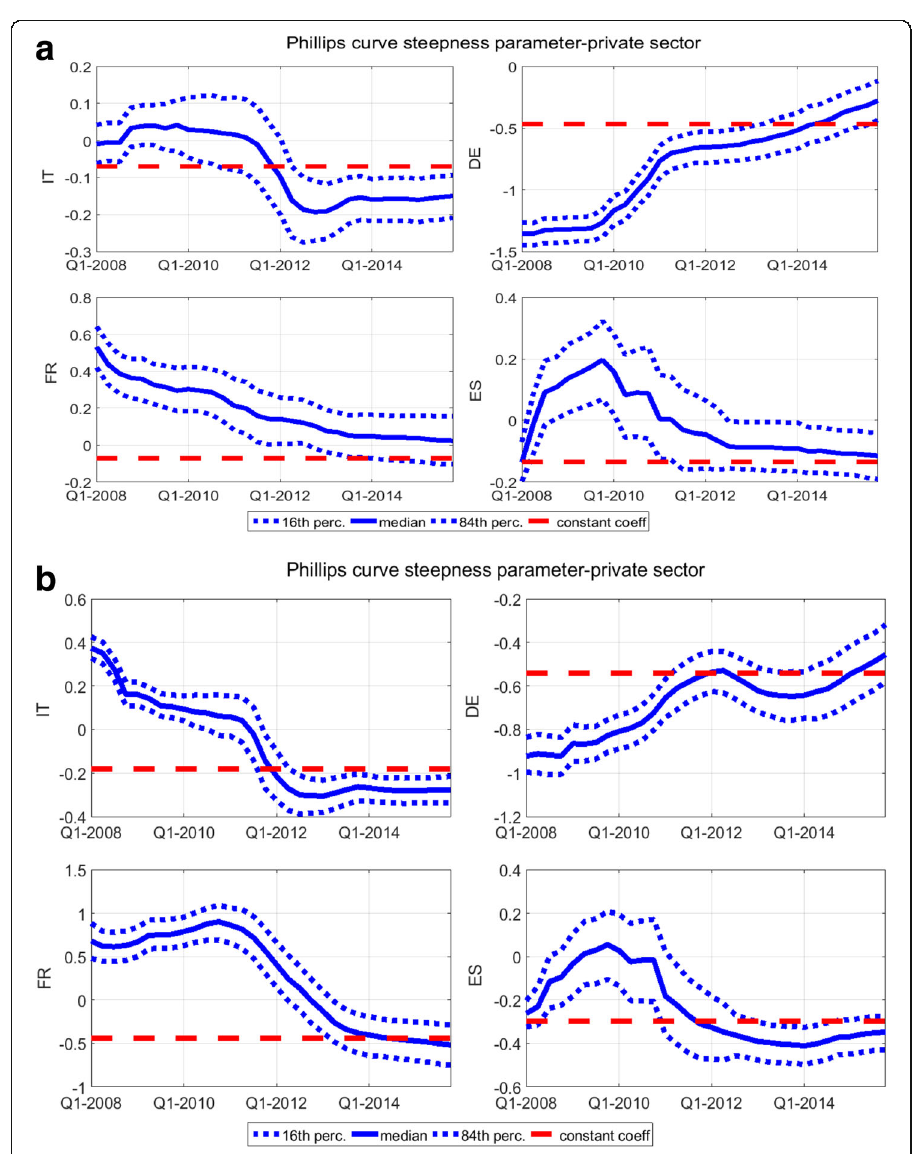
Fig. 4 Country-specific evidence of instability of the unemployment parameter in wage Phillips curve. a Δ 4